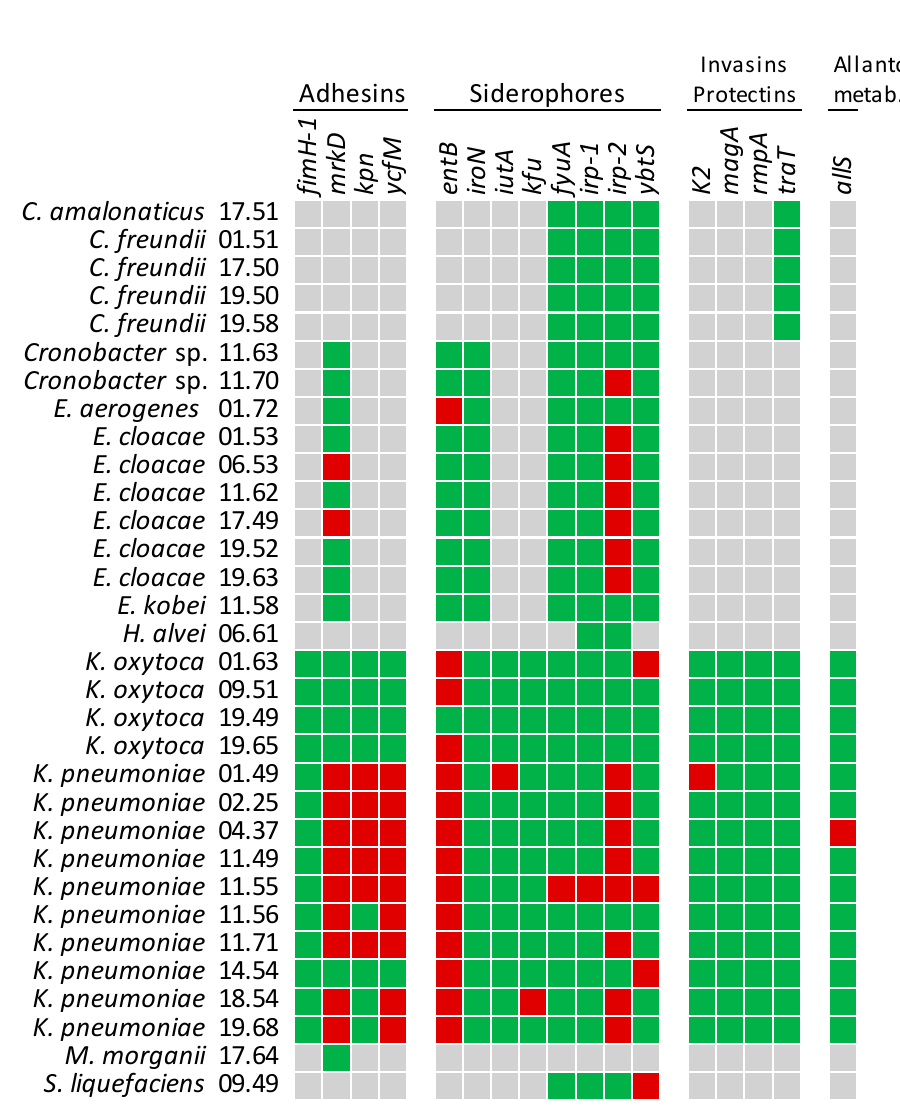
Figure 3. PCR assay of the NECE isolates for the presence of virulence genes. Colors: red, positive amplification; green, negative amplification; grey, PCR analysis not performed since the gene was putatively absent based on a primer-blast search.